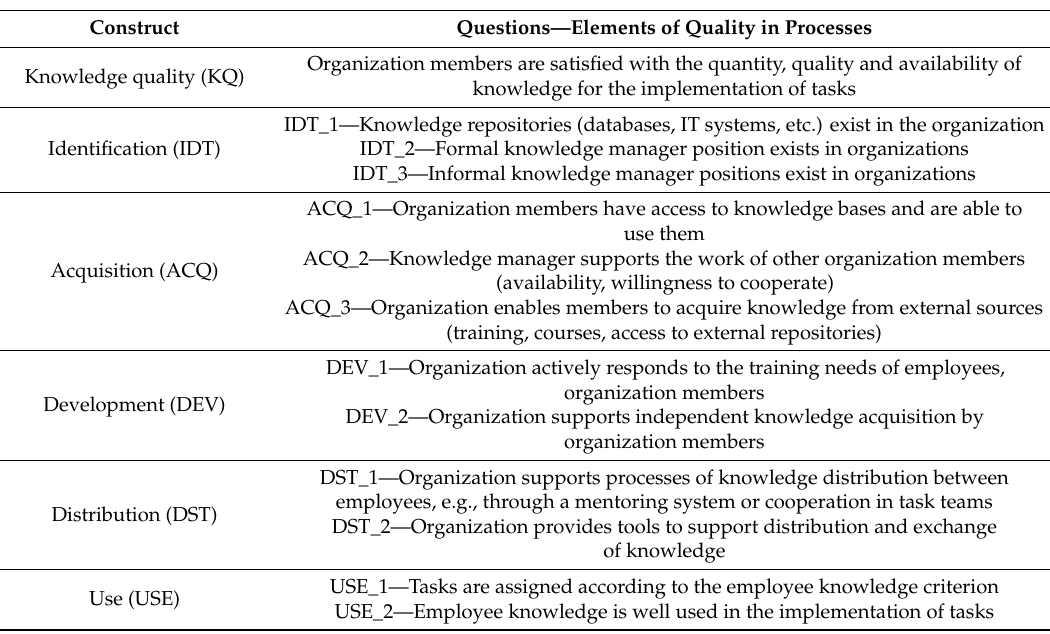
Table4. Elementsinfluencingevaluationofthestateofknowledgemanagementqualityinorganizations.